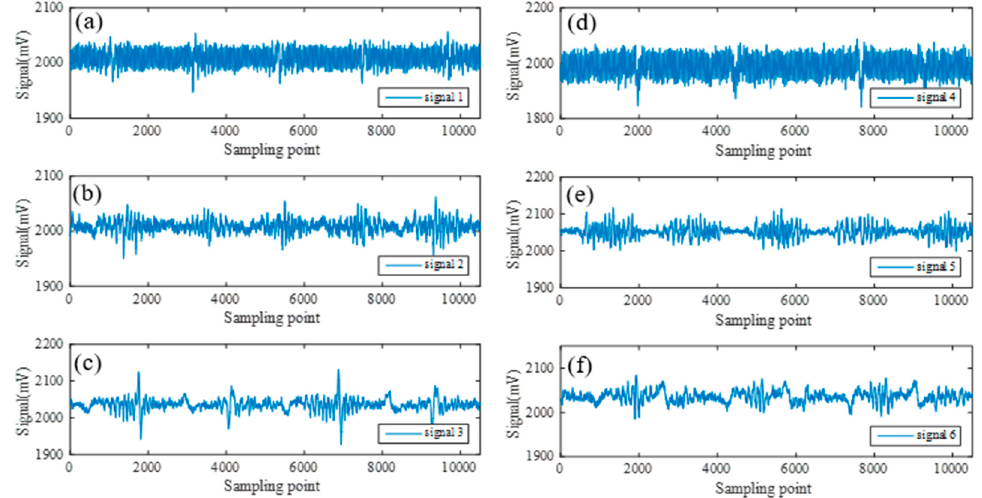
Figure 2. Weak signals of steel wire rope with different defects and liftoff distances. ( a ) Signal 1 of one-wire broken defect from sample 1 with liftoff distance of 13 mm; ( b ) Signal 2 of three-wire broken defect from sample 1 with liftoff distance of 13 mm; ( c ) Defect signal 3 from sample 2 with liftoff distance of 13 mm and coil sensor; ( d ) Defect signal 4 from sample 3 with liftoff distance of 13 mm; ( e ) Defect signal 5 from sample 3 with liftoff distance of 20 mm; ( f ) Defect signal 6 from sample 2 with liftoff distance of 20 mm and coil sensor. The signals 1, 2, 4, and 5 are detected with the sensor of the inductive transducer, while signals 3 and 6 are tested with copper coils.